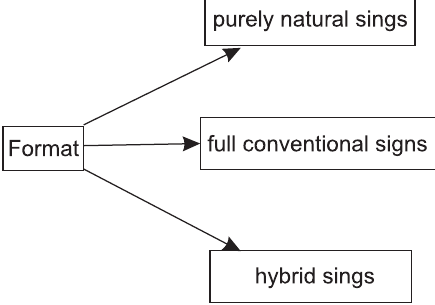
Schema 1. The format of